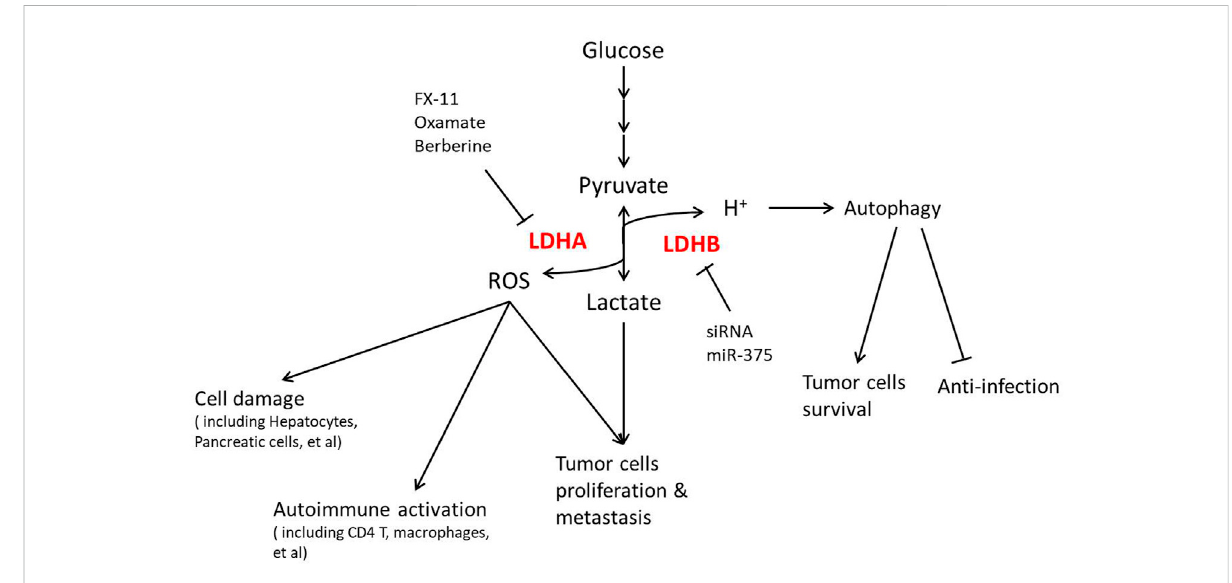
FIGURE 3 LDH regulation in diseases and clinical